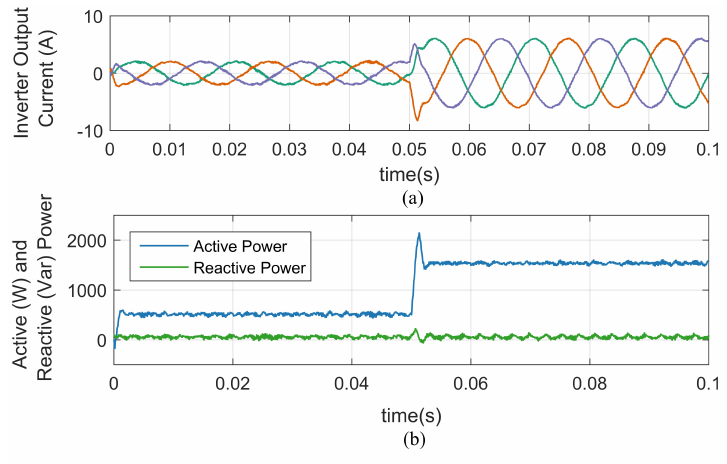
Figure 8. Simulation results with the PI controller. ( a ) Three-phase output current of the inverter. ( b ) Active and reactive power